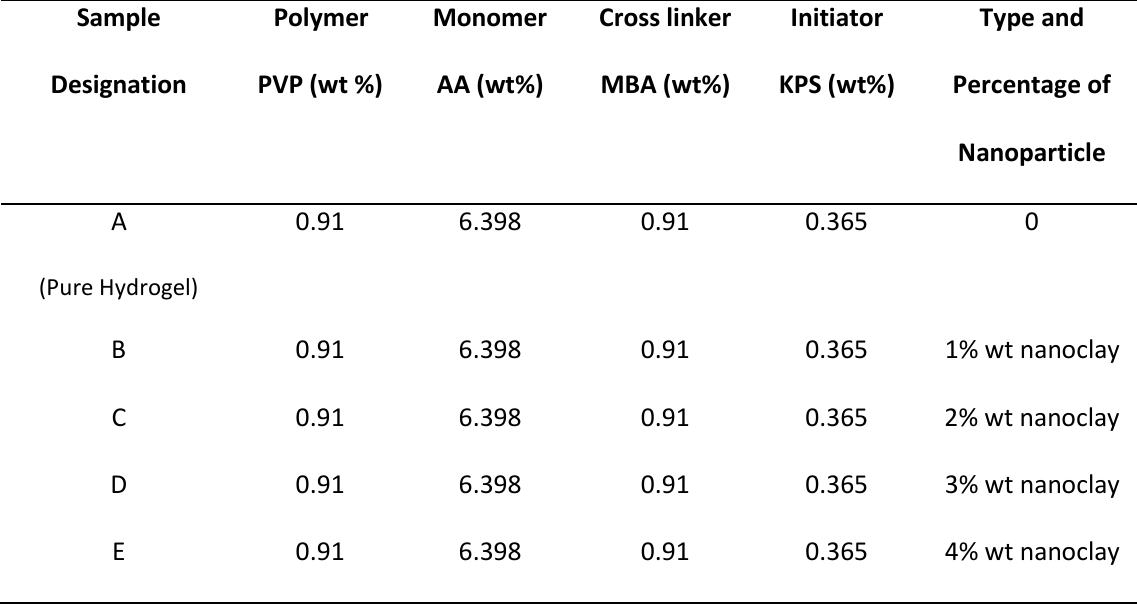
Table 1. Experimental weight percent of ingredients of the